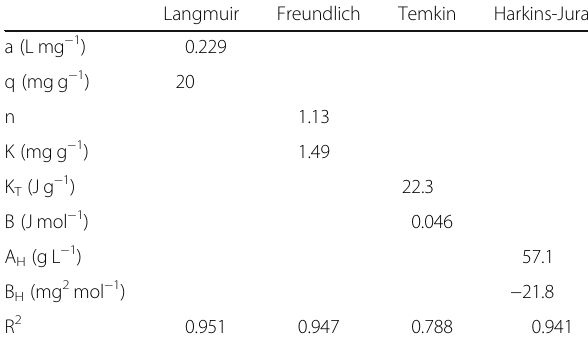
Table 3 The constant of